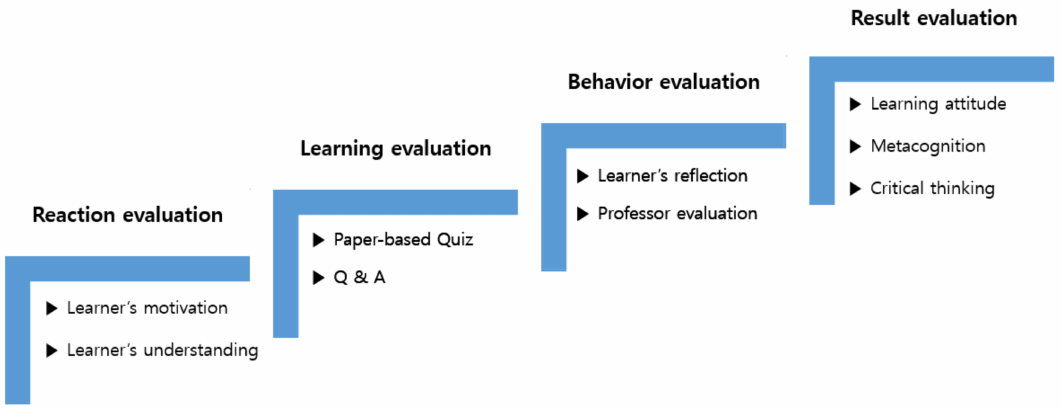
Figure 1. Framework of simulation problem-based learning